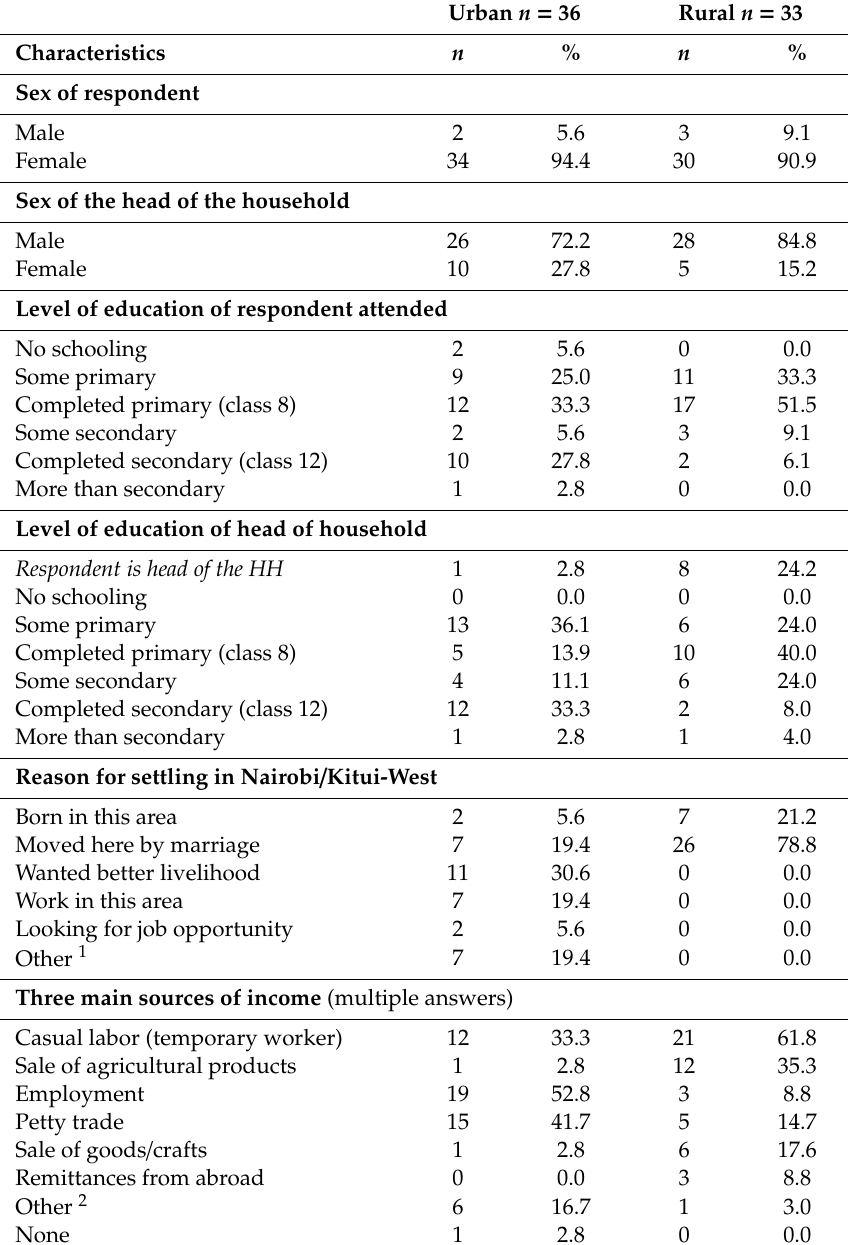
Table 8. Descriptive characteristics of households of the schoolchildren enrolled in the